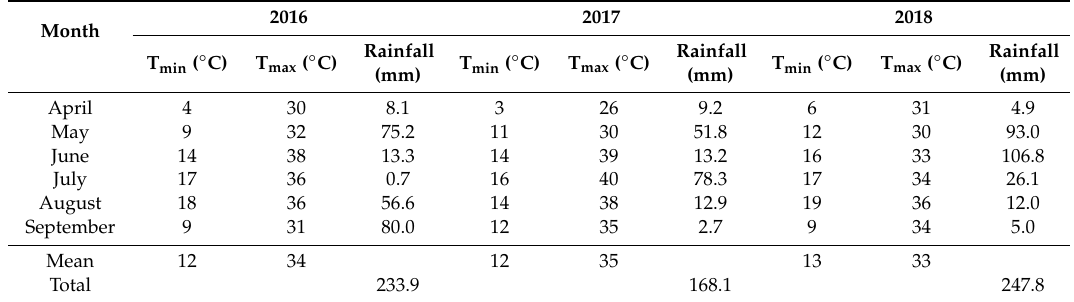
Table 2. Monthly mean maximum temperature (T max ), minimum temperature (T min ), and total rainfall during the growing seasons of industrial hemp at Thessaloniki (Greece) in 2016, 2017, and